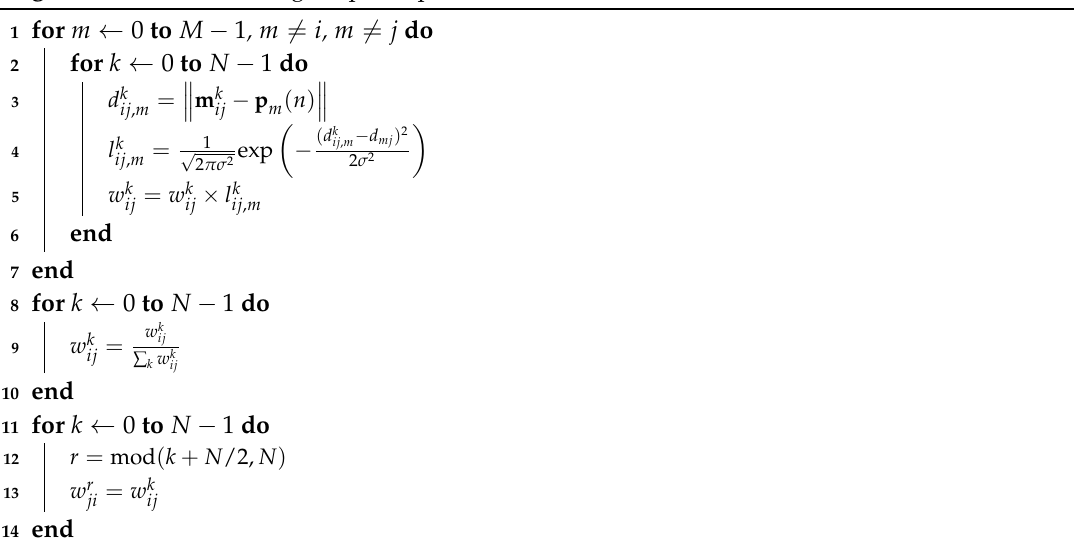
Algorithm 4: Efficient weight update